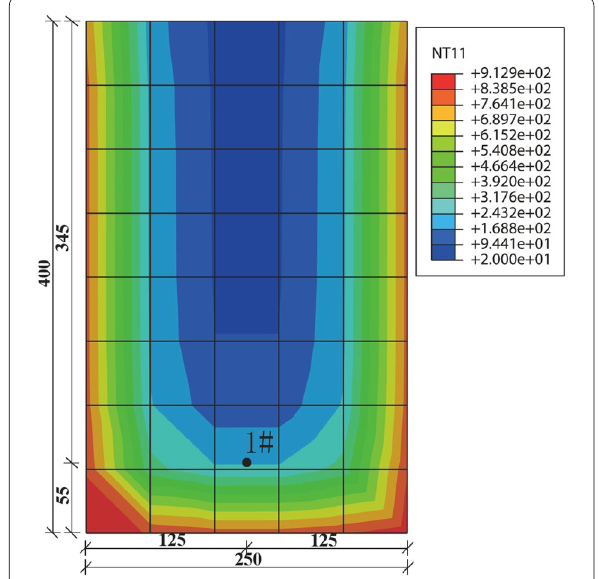
Fig. 22 Nephogram of temperature field of L5 beam after 1 h of fire exposure